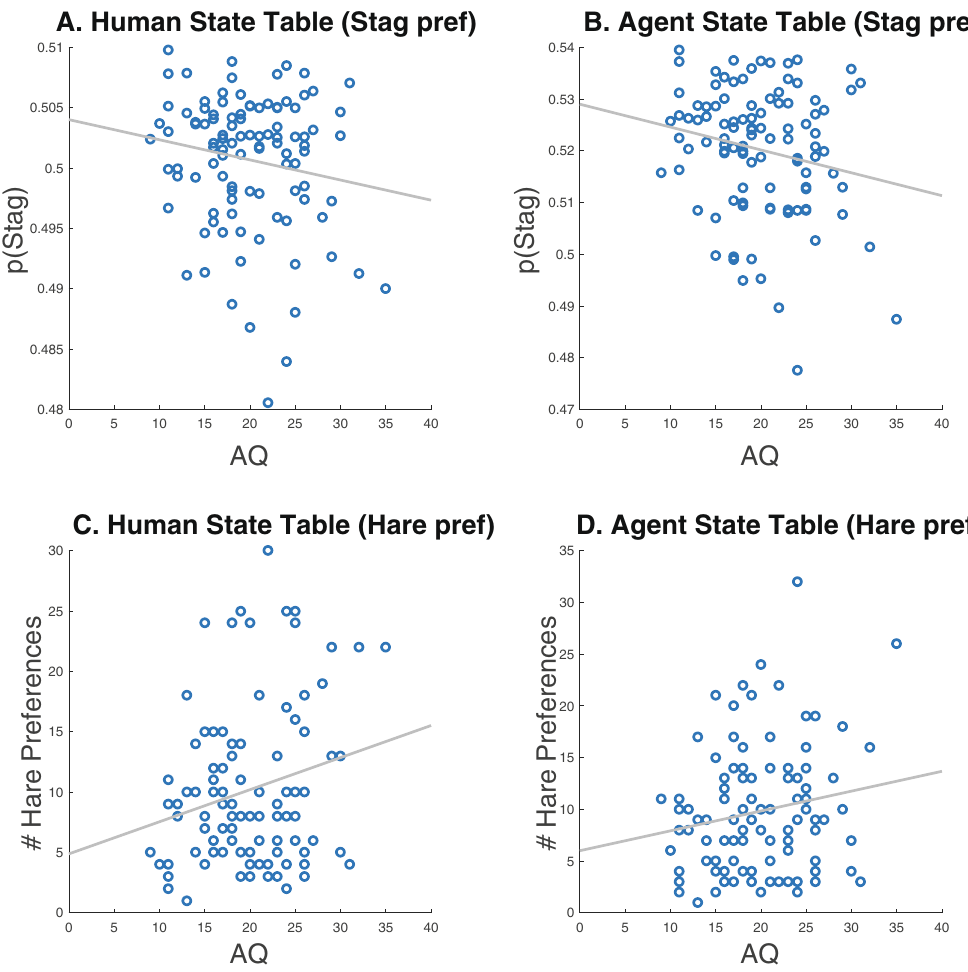
Figure 8. Target preference as measured by the human and agent actor state tables constructed by the ToMPlan agent. ( A ) Average weights for stag preference in the human state table. ( B ) Average weights for stag preference in the agent state table. Subject AQ was negatively correlated with state table weights for the agent (r = − 0.195, p < 0.05). ( C ) Number of entries in the human state table, where the likelihood to hunt hare was greater than 60%. AQ was positively correlated with the likelihood to hunt hare (r = 0.224, p < 0.022). ( D ) Number of